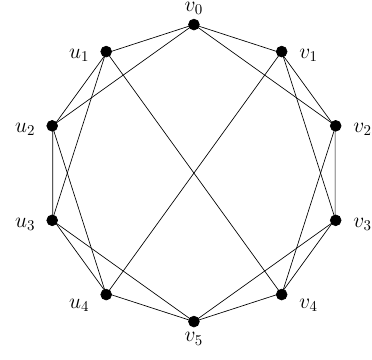
Fig. 3: The graph F 5 has colouring number 5 and all edges of F 5 , except u 1 v 4 and v 1 u 4 , are double- col